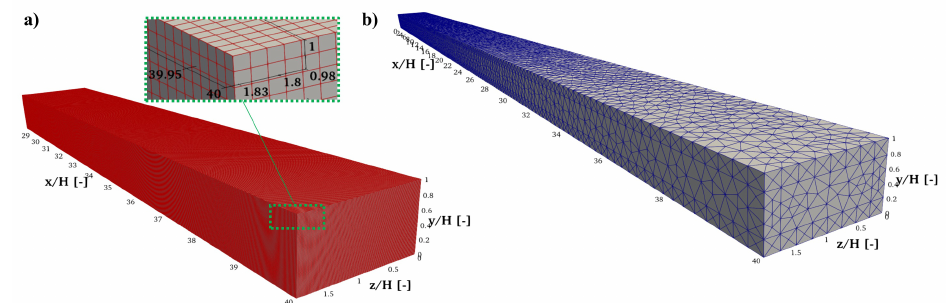
Figure 3. Meshes used for the simulation of the free decay of an oscillating aircraft-wing-like structure with a sloshing tank with ( a ) fluid mesh and ( b ) structure